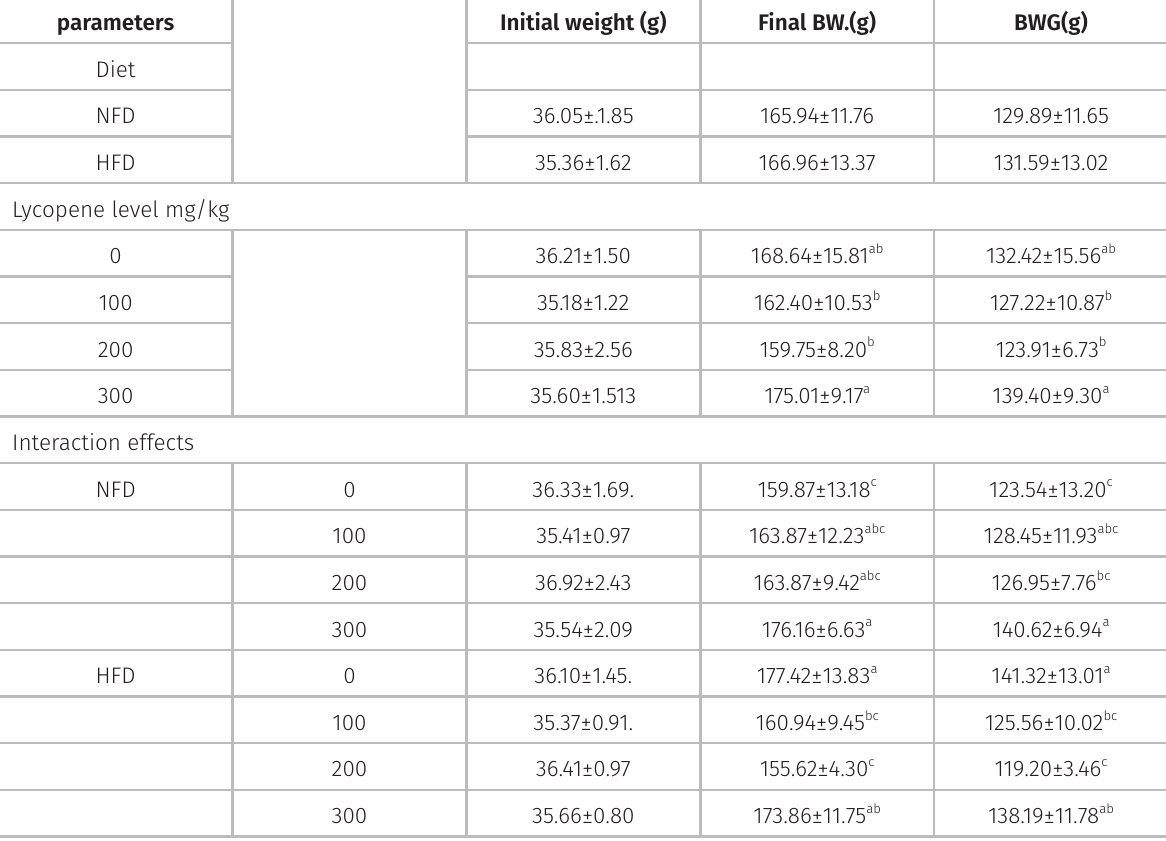
Table II. Effects of graded levels of lycopene supplementation to normal fat diet (NFD) and high-fat diet (HFD) on the final body weight and body weight gain of growing Japanese